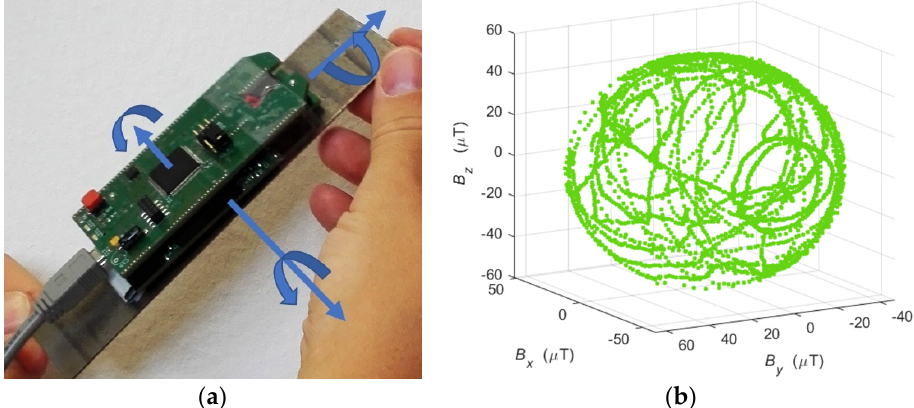
Figure 4. Sample rotation procedure with the sensor matrix ( a ) sample result of the recorded mag- netic field creating a characteristic sphere for one selected sensor from the matrix ( b ).